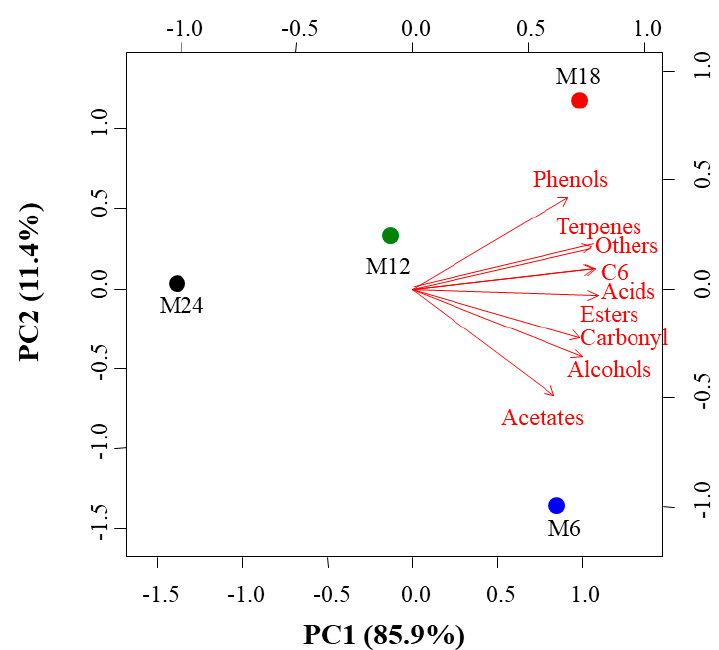
Figure 1. Principal component analysis (PCA) of Treixadura wines after several months of aging in the bottle: Bi-plot of the first two components (PC) for families of volatile compounds related to wine aroma. M6, M12, M18, and M24 indicate 6, 12, 18, and 24 months after bottling.